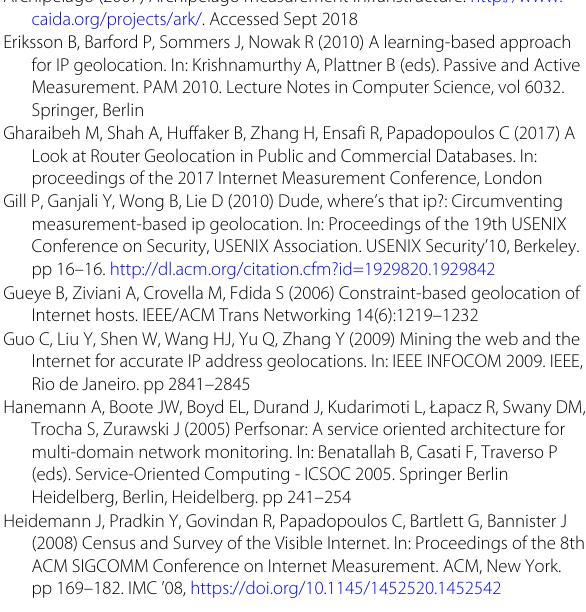
discovering intermediate routers as secondary landmarks is presented in this paper. The proposed method takes advantage of passive landmarks to perform topology mea- surements without the limitation of the distribution of vantage points. It finds frequently appeared common routers. Most of them can be geolocated by existing land- marks and routes. These common routers have more information than other nodes. The proposed method chooses these routers as secondary landmarks to help increase landmark density. This method works well in regions with sparsely distributed landmarks. We have evaluated our method in Beijing on university and city dataset with different landmark densities. Experimental results show that we manage to reduce long tail effect on all datasets, especially on university dataset by about 50%. Our work manages to decouple geolocation result from vantage points and landmark densities. The proposed method can be further improved by replacing maximum likelihood estimation to other methods that take network structures into